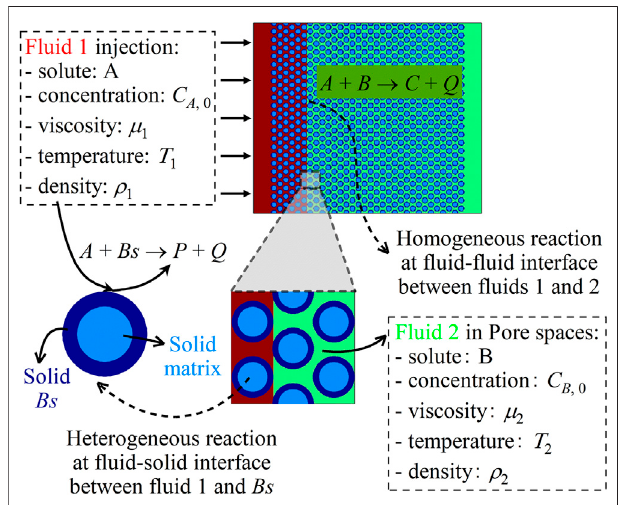
FIGURE 1 | Schematic of the fl ow con fi guration with chemical reactions in porous